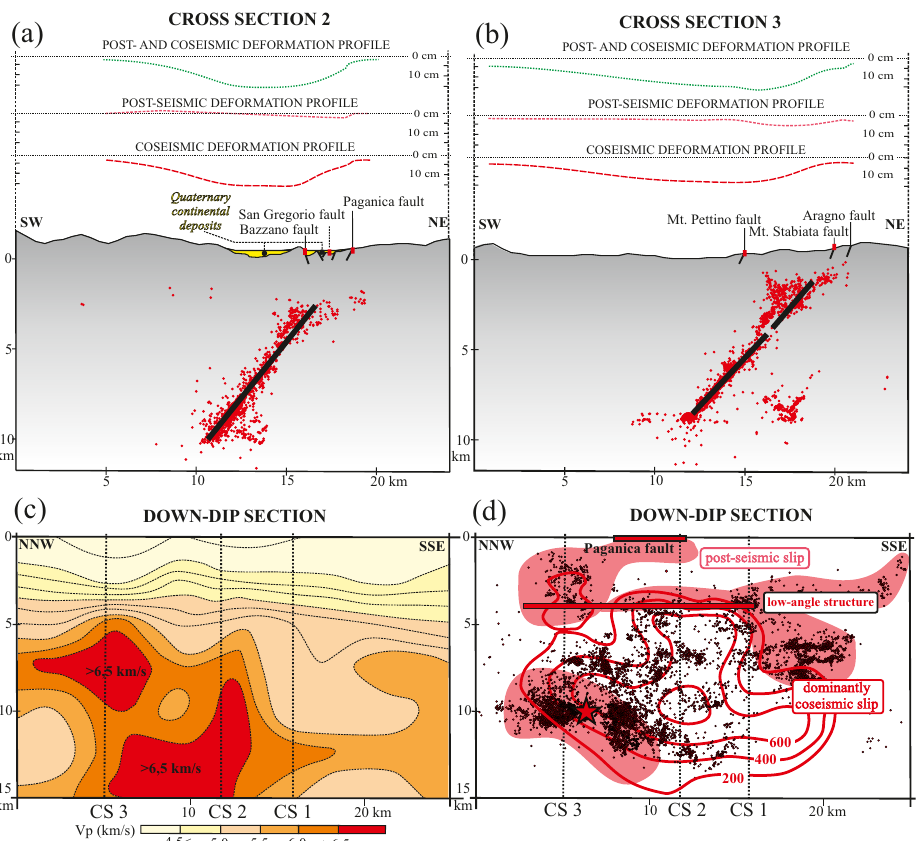
Figure 4. (a) and (b) : cross sections, showing dominantly coseismic (4 April 2009–12 April 2009; D’Agostino et al., 2012), post-seismic (12 April–5 October 2009; D’Agostino et al., 2012) and cumulative elevation changes measured along the section trace. In all figures red dots indicate relocated aftershocks (Valoroso et al., 2013). Thick black lines represent the fault plane derived by geodetic inversions with coseismic slip (Atzori et al., 2009). Section traces are shown in Figs. 1 and 2. (c) and (d) : down-dip sections along the L’Aquila master fault (strike N135E; dip 50 ◦ to the WSW); (c) shows Vp values imaged along the fault plane (from Di Stefano et al., 2011); (d) shows the mainshock location (star). Red dots are aftershocks located within 0.5km of the fault plane (Chiaraluce et al., 2011). Coseismic slip pattern, shown by red lines (contour interval is 200mm; Atzori et al., 2009), and location of the inferred inherited thrust faults (orange thick lines). Red areas mark portions of the fault that experienced post-seismic slip (modified from D’Agostino et al.,